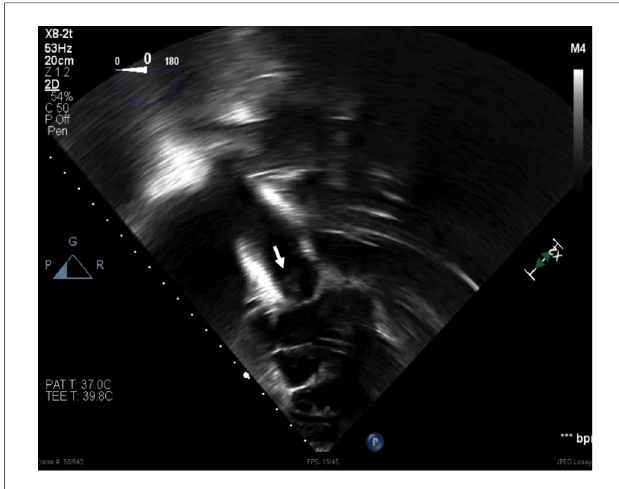
FIGURE 1 A mobile structure (arrow) visualized in the pulmonary valve from trans- gastric view on transesophageal echocardiogram. The structure moved with the valve, well attached to the lea fl